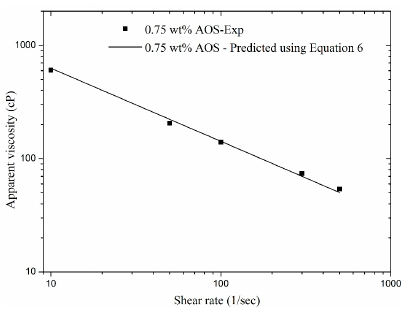
Figure 6. Validation of Equation (6).